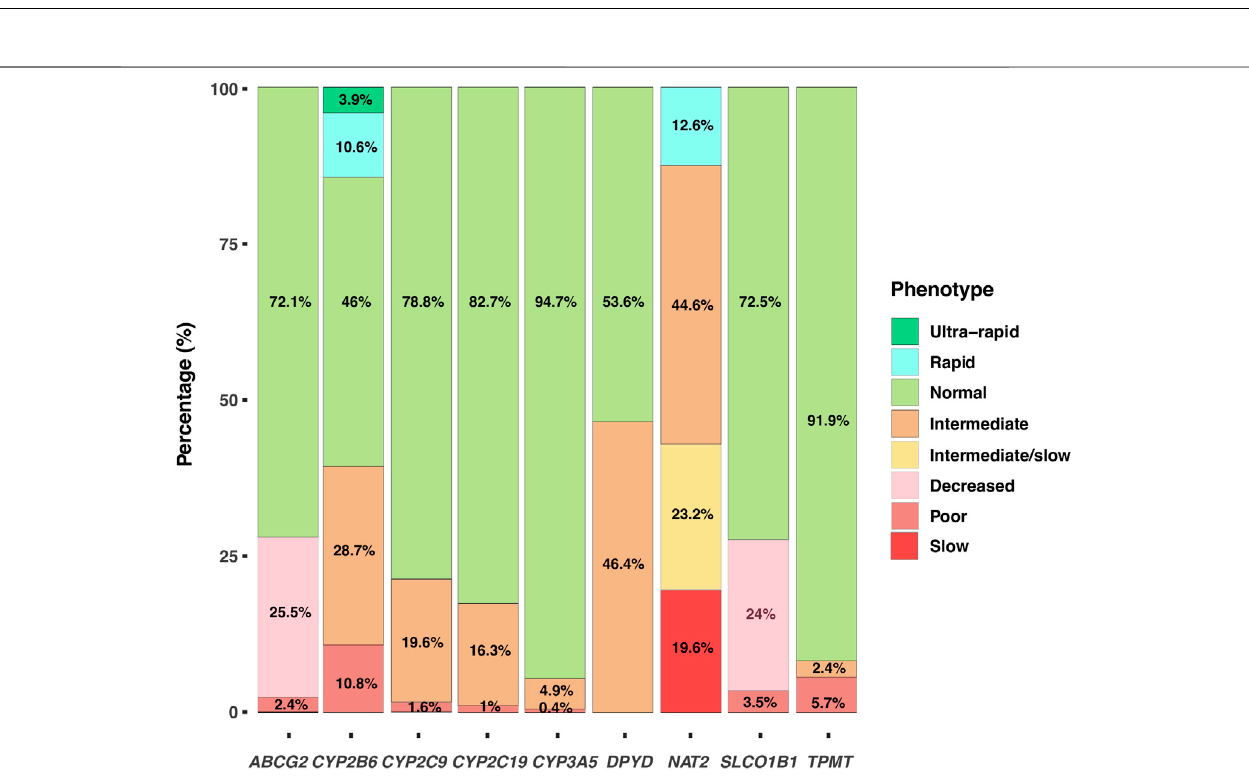
FIGURE 3 | Metabolizer Phenotypes. Distribution of the metabolizer phenotypes based on the diplotypes for the genes ABCG2 , CYP2B6 , CYP2C9 , CYP2C19 , CYP3A5 , DPYD , NAT2 , SLCO1B1 and TPMT .